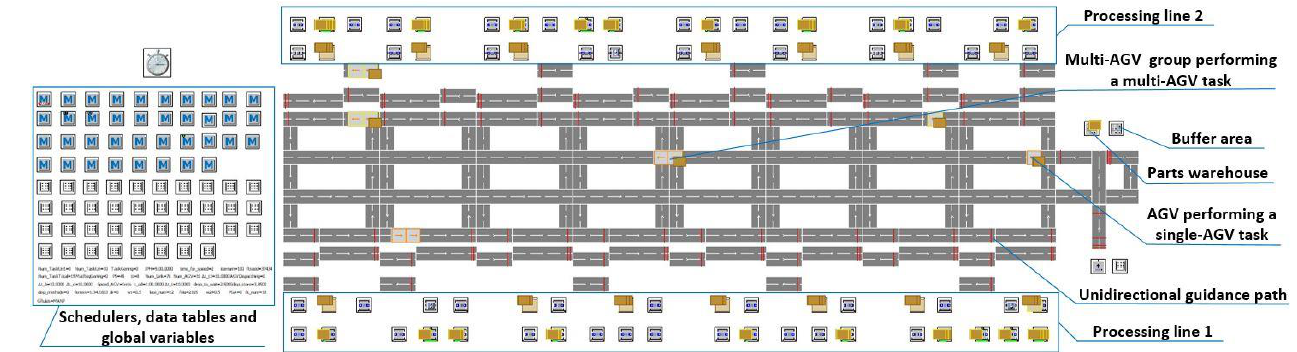
Figure 4. The simulation interface of AGV system for transporting materials in a BCAL. Table 2. The settings of stations.